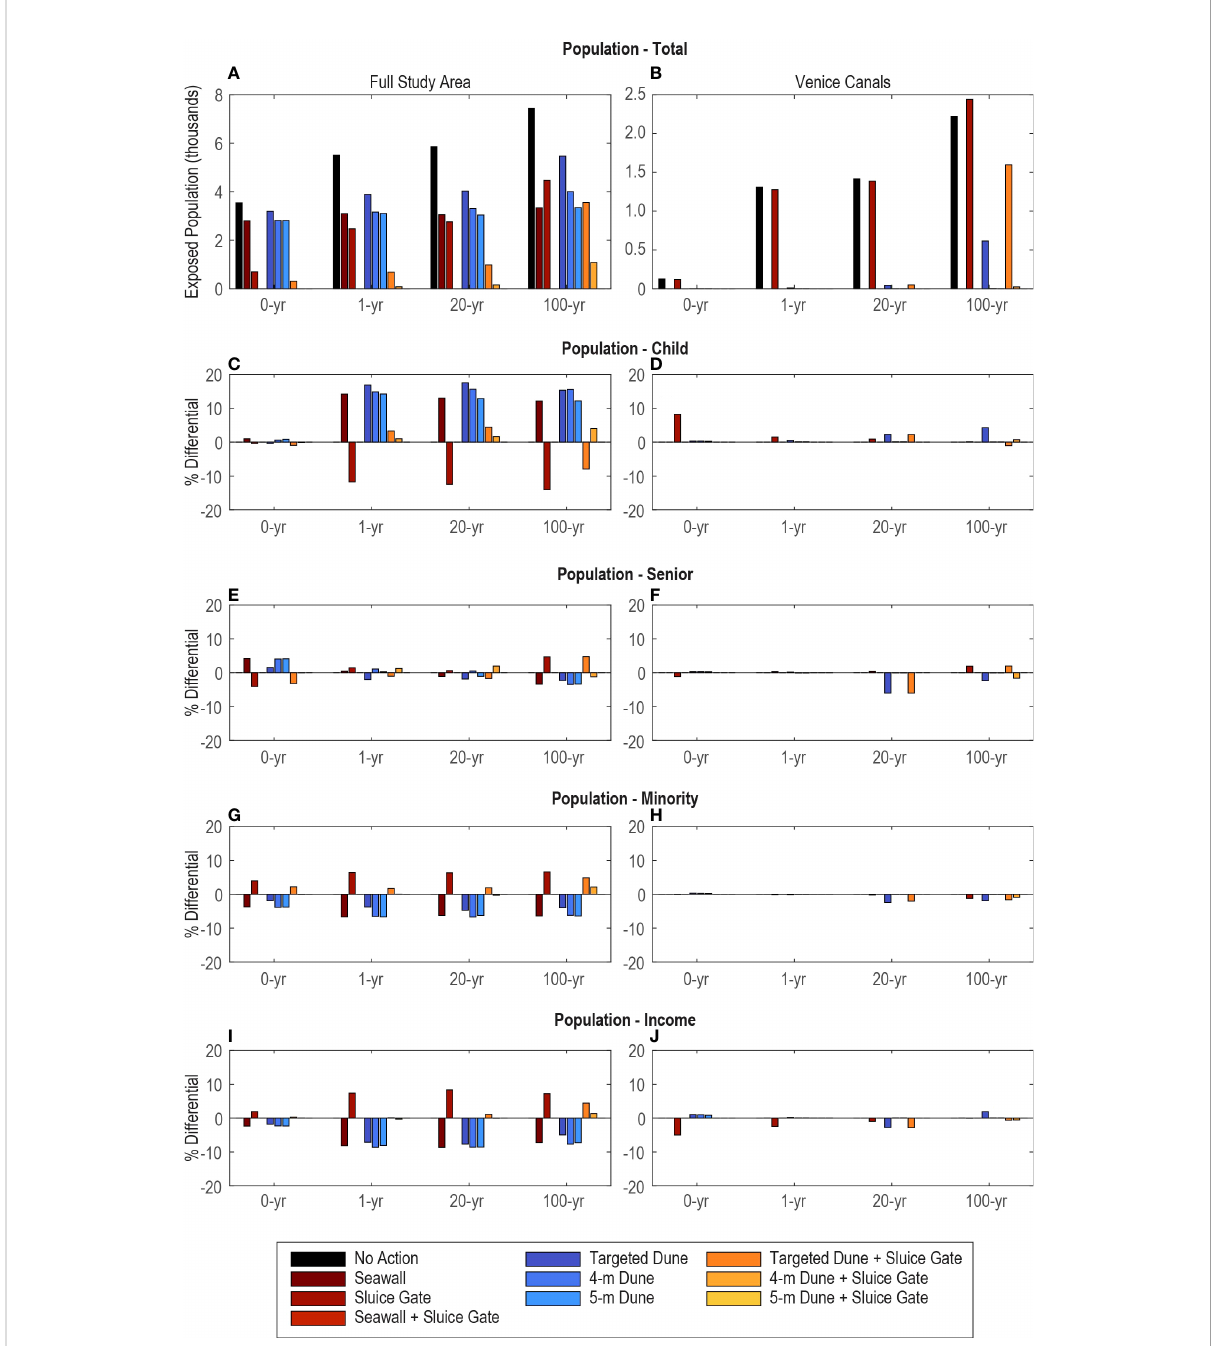
FIGURE 5 Simulated total exposed population (A, B) and percent differential for child (C, D) , senior (E, F) , minority (G, H) , and low-income (I, J) populations for each adaptation approach across the range of storm scenarios. Positive bars indicate a higher level of protection for the speci fi ed demographic group as compared to the entire population, while negative bars represent a lower level of protection. Results for the full study area are shown in the left column and the Venice Canals in the right